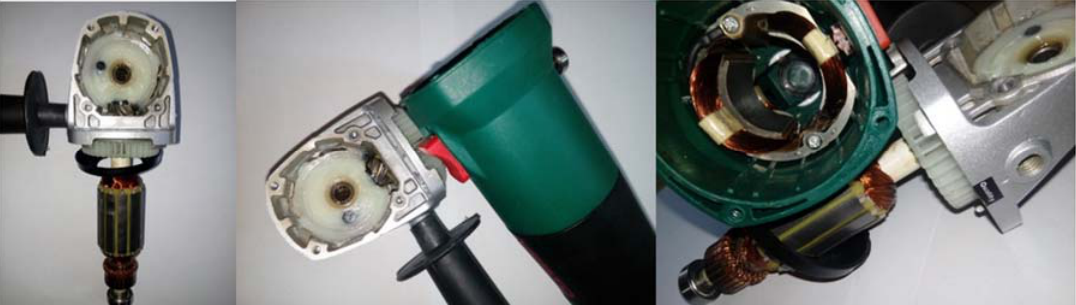
Figure 6. Parts of angle grinder (commutator motor, stator, fan, bearing). 4.1. BCAoMID − F (Binarized Common Areas of Maximum Image Di ff erences − Fusion)